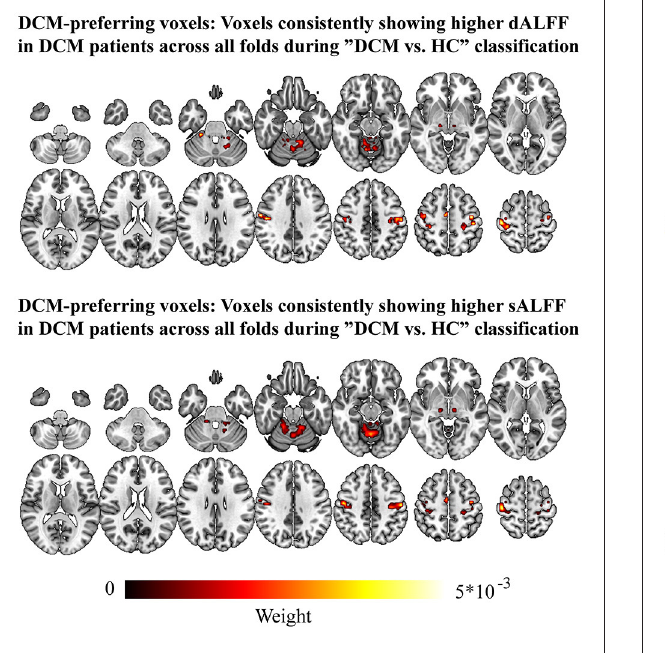
FIGURE 3 | Voxels showed higher weight for classification for “DCM vs. HC” across all folds. DCM, Degenerative Cervical Myelopathy; HC, Healthy Controls. FIGURE 4 | Brain regions with significant classification accuracy for “DCM vs.